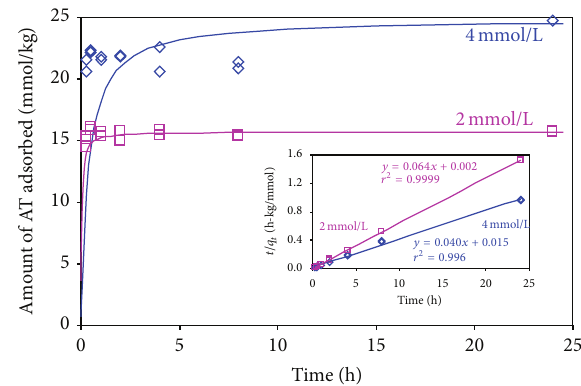
Figure 3: Kinetics of AT adsorption on kaolinite from initial concentrations of 2 and 4mmol/L. The lines are pseudo-second- order fits to the observed data. Inset is the plot based on